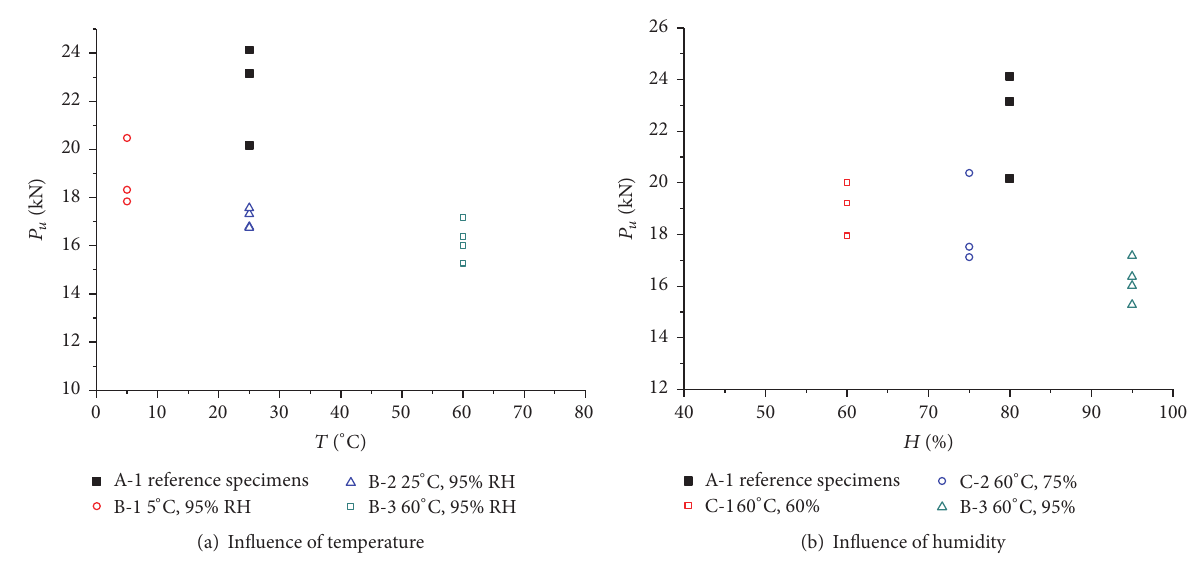
Figure 9: Influence of the hygrothermal environment on the ultimate load.